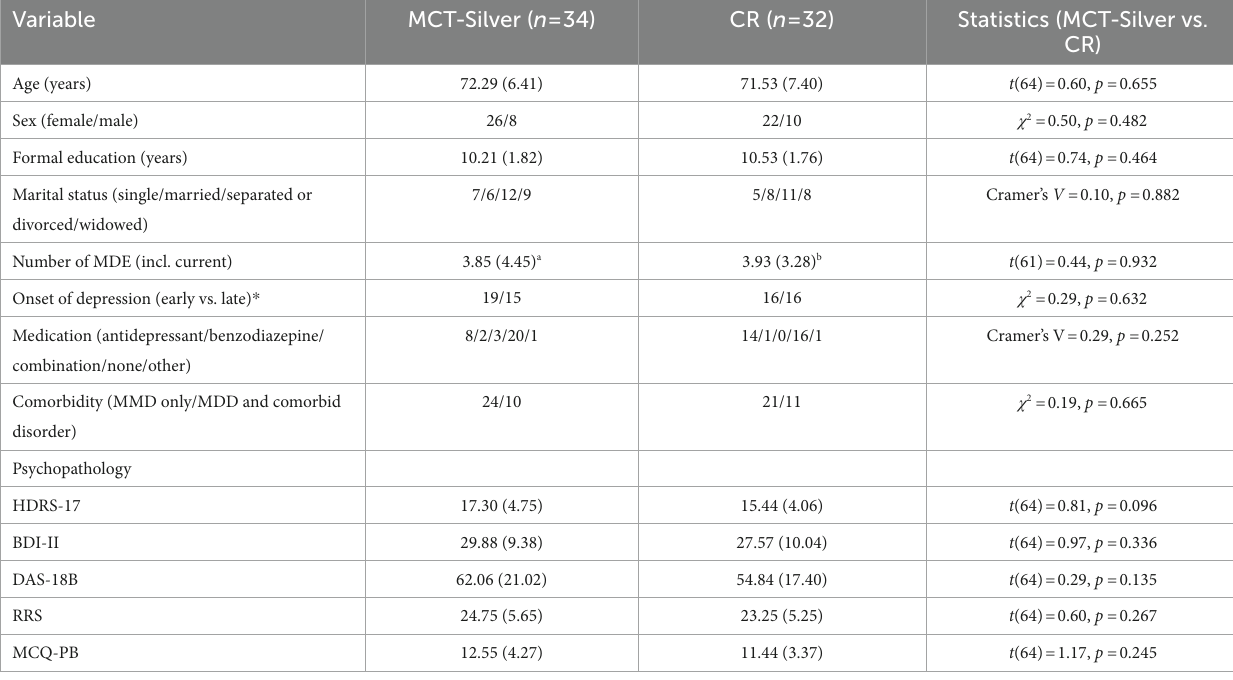
TABLE 1 Baseline sociodemographic and clinical characteristics: Means (SD) or frequencies.